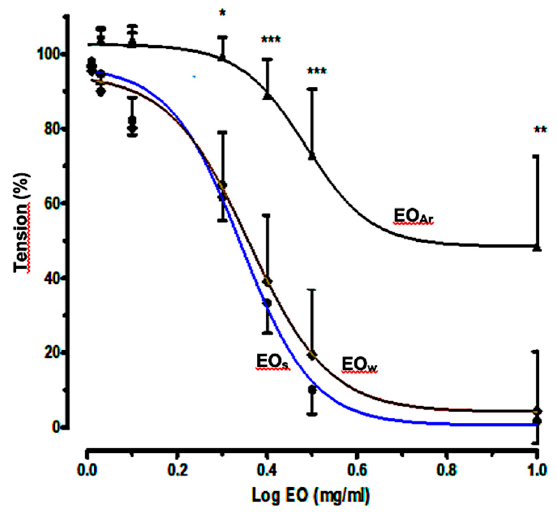
Figure 2. Concentration–response curves for the relaxant effects of volatile fractions EO S , EO W , and EO Ar on rat aortic rings precontracted with phenylephrine (1 µ M). * p < 0.05, ** p < 0.01 and *** p < 0.001. Table 2. Relaxant effects of EO S , EO W , and EO Ar on rat aortic rings precontracted with phenylephrine (1 μ M).